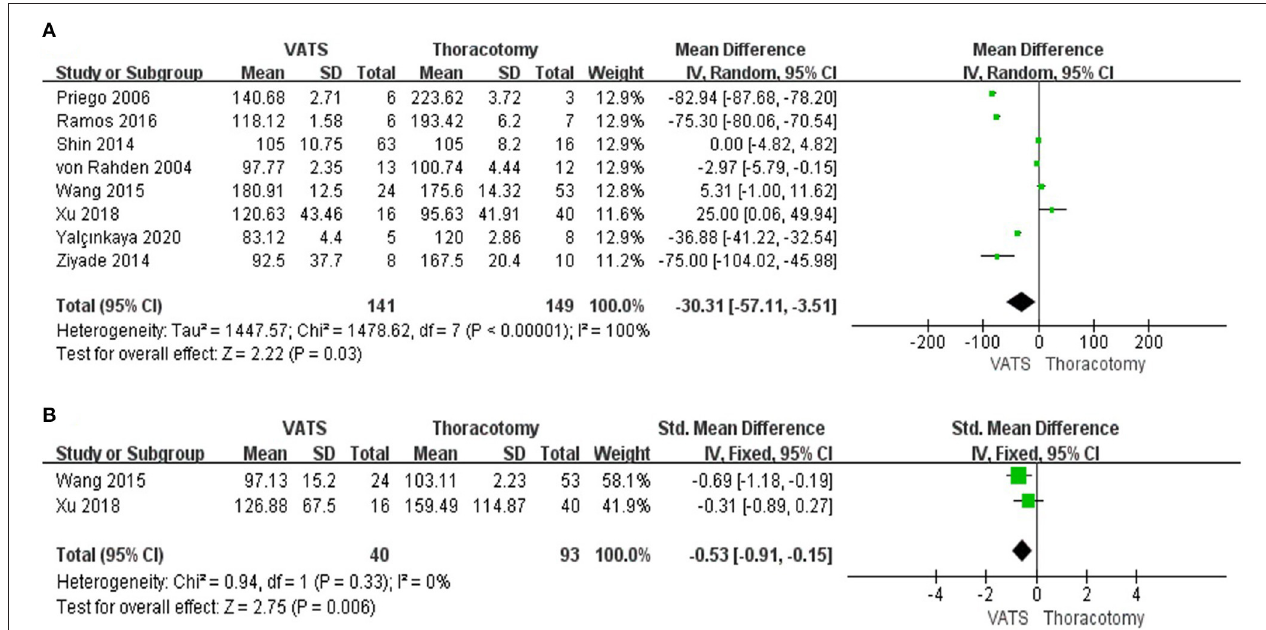
FIGURE 2 | Forest plot of the meta-analysis. (A) Operation time. (B) Estimated blood